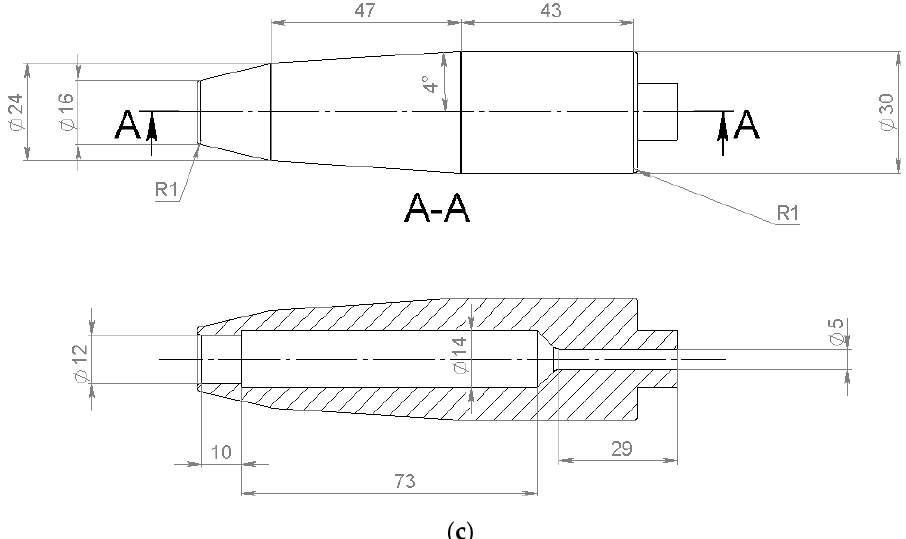
Figure 2. Plugs for piercing the ingots: the entire plug ( a ), the plug with a cavity ( b ), and the hollow plug ( c ).